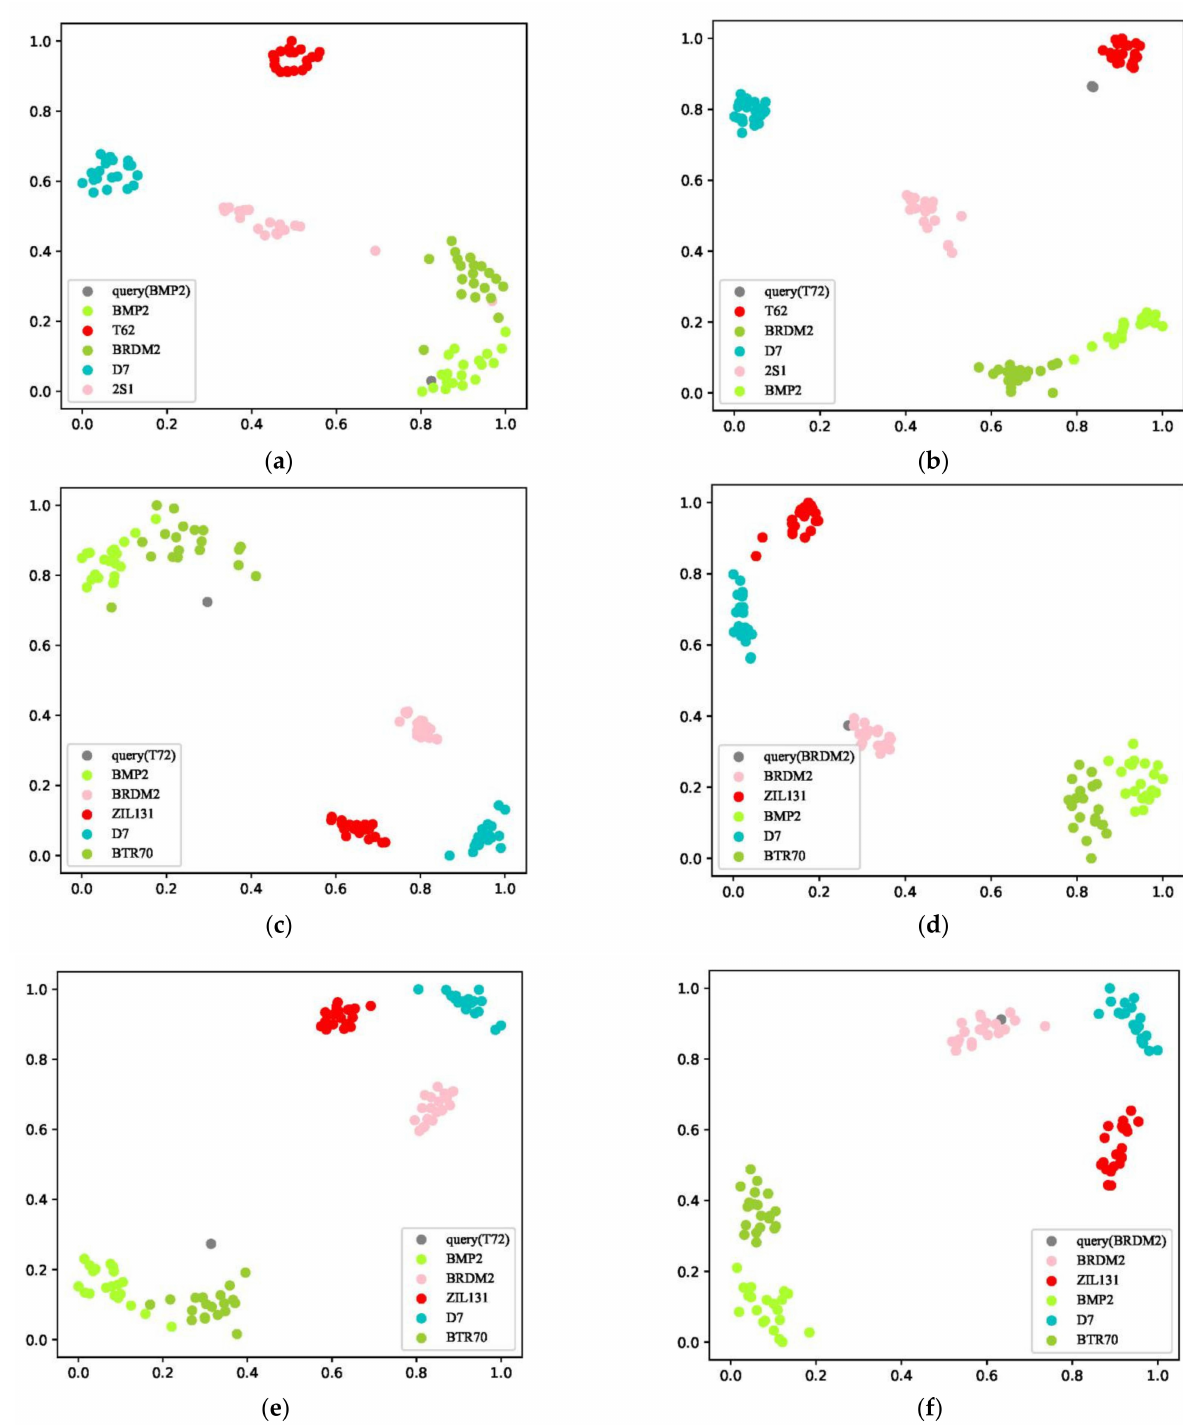
Figure 6. Distributions of the features of samples in different test tasks. The categories in T s of ( a , b ) are the same; the categories in T s of ( c , d ) are the same; the categories in T q of ( b , c ) are the same; the categories of ( c , e ) are the same, but the samples are different; the categories of ( d , f ) are the same, but the samples are